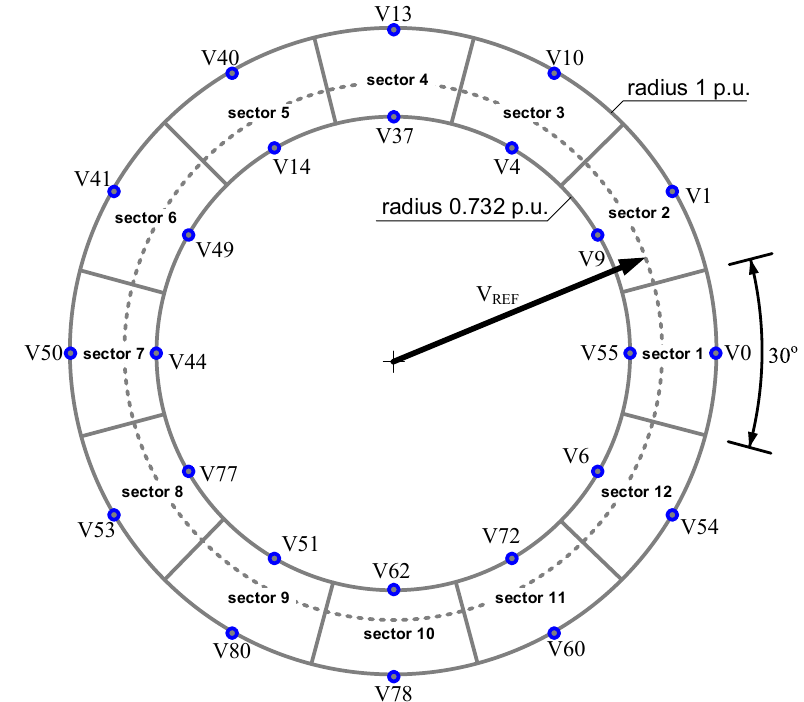
Figure 10. The PWR modulation workspace for S MC p switch states.